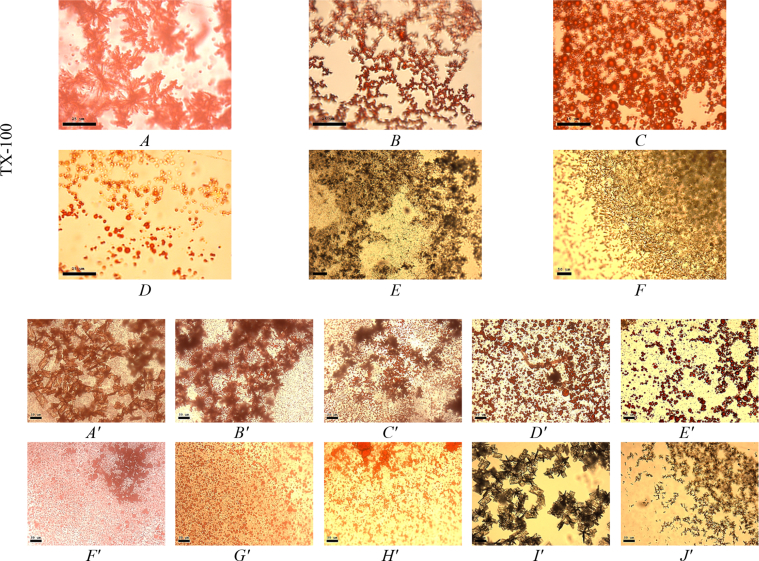
Effect of csurfactant: cchelator ratio (cM/cM) on clustering processes during 15 min. For TX-100 from A to D: 0.60, 0.85, 1.35, 2.85 (scale bar is 25 μm), control samples (without Fe2+ salt), E, F for critical cases 0.50 and 2.375, respectively (scale bar is 50 μm) and for TX-114 from A′ to H’: 0.064, 0.1, 0.15, 0.225, 0.35, 0.60, 1.35, 2.85, control samples (without Fe2+ salt), I', J' for critical cases 0.064 and 2.85, respectively (scale bar is 50 μm).